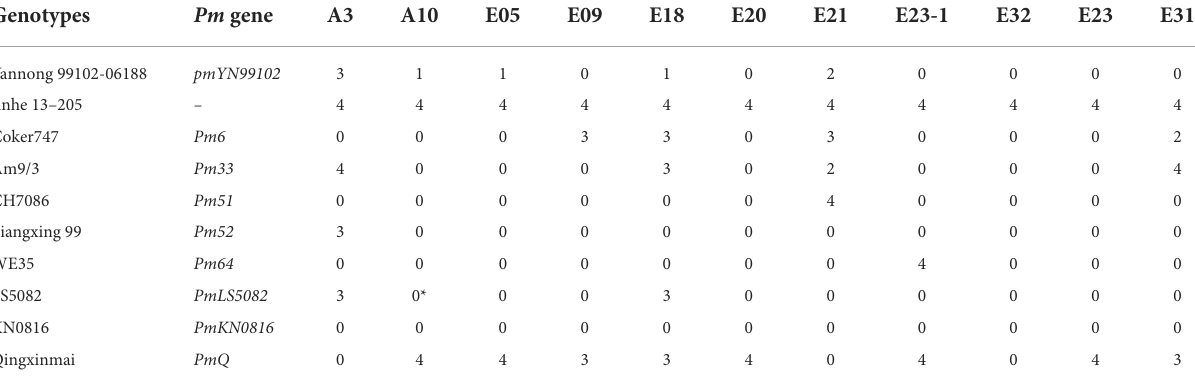
TABLE 1 Comparative responses of Yannong 99102-06188 and wheat genotypes with known powdery mildew resistance genes on chromosome arm 2BL to 11 isolates of Blumeria graminis f. sp. tritici ( Bgt ) with different virulence.